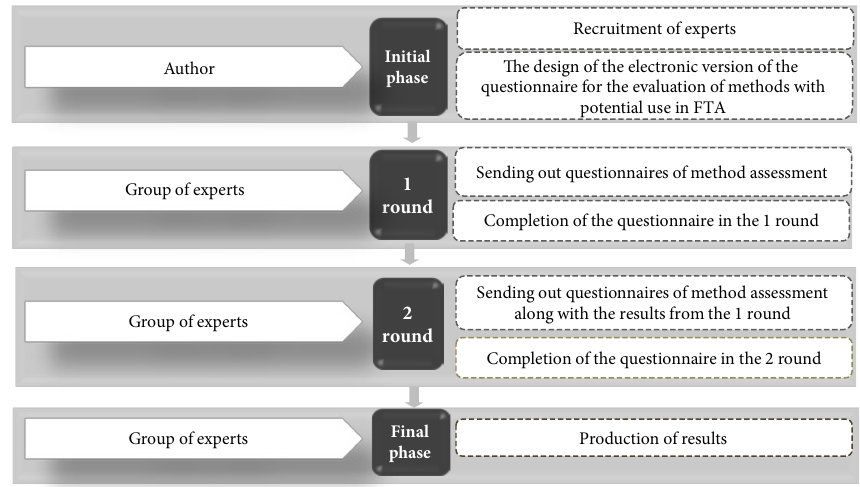
Fig. 2. Research process using the mini-Delphi method